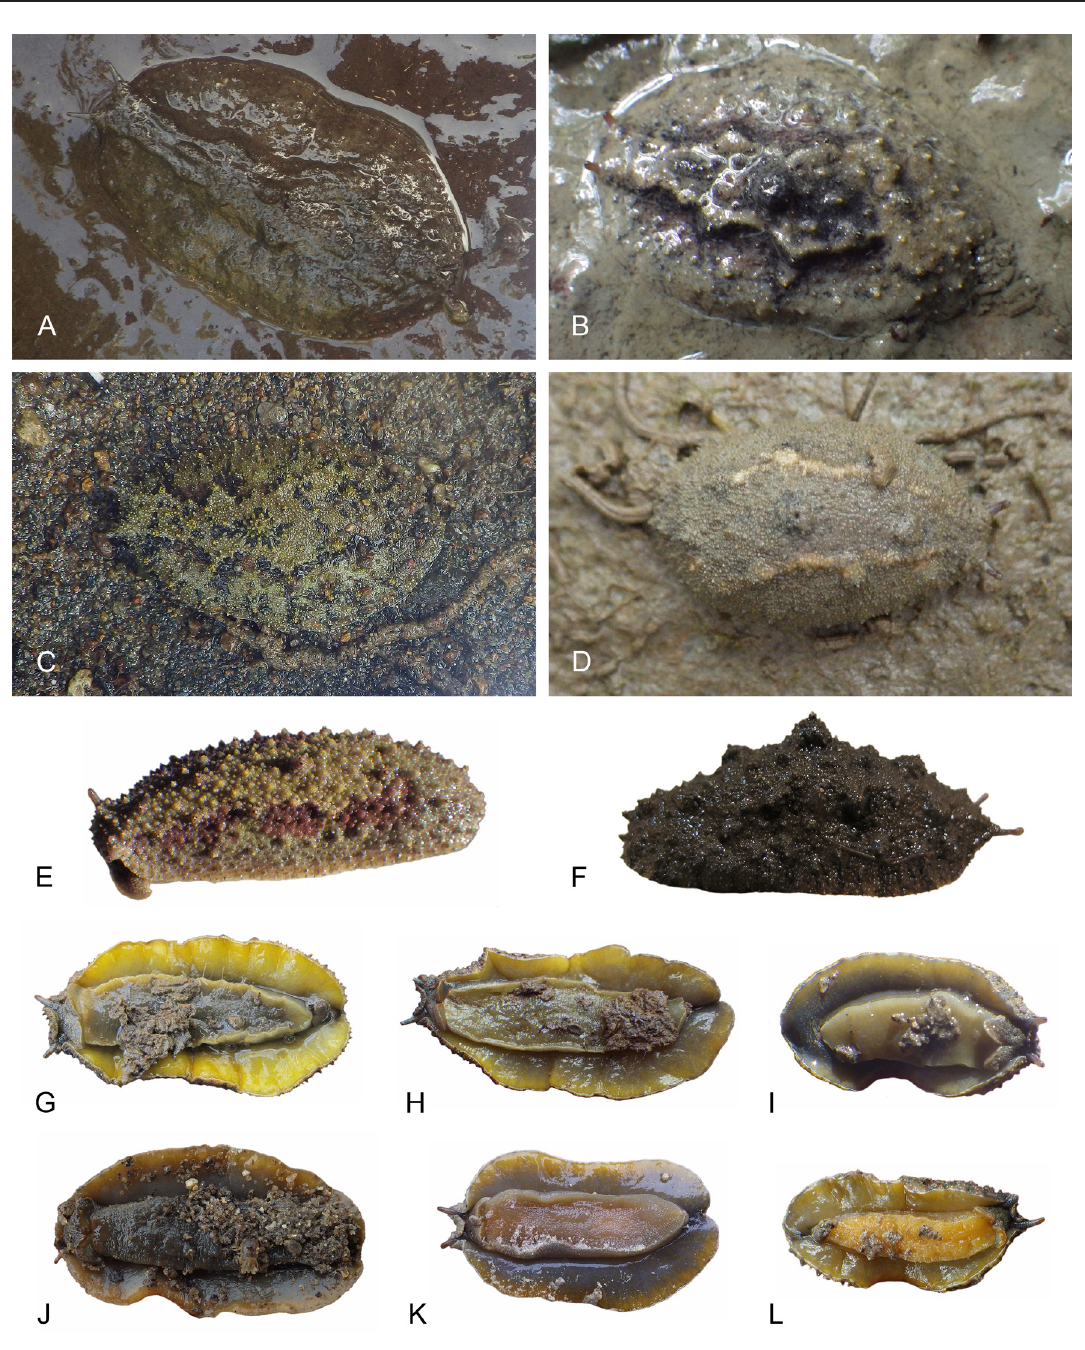
Fig. 8. Paromoionchis tumidus (Semper, 1880) comb. nov. unit #1, live animals. A . Dorsal view, 55 mm long [5103], Indonesia, Halmahera (UMIZ 00136). B . Dorsal view, 22 mm long [1732], Indonesia, Sumatra (UMIZ 00121). C . Dorsal view, 22 mm long [5082], Indonesia, Halmahera (UMIZ 00135). D . Dorsal view, 22 mm long [5642], Vietnam (ITBZC IM 00020). E . Dorsal view, 45 mm long [2657], Australia, Queensland (MTQ). F . Dorsal view, 31 mm long [1522], Australia, New South Wales (AM C.468918.005). G . Ventral view, 42 mm long [1686], Australia, Northern Territory (NTM P.57621). H . Ventral view, 47 mm long [2562], Australia, Queensland (MTQ). I . Ventral view, 19 mm long [2961], Indonesia, Lombok (UMIZ 00132). J . Ventral view, 44 mm long [5619], Vietnam (ITBZC IM 00019). K . Ventral view, 33 mm long [3416], Philippines, Bohol (PNM 041260). L . Ventral view, 24 mm long [3371], Philippines, Bohol (PNM